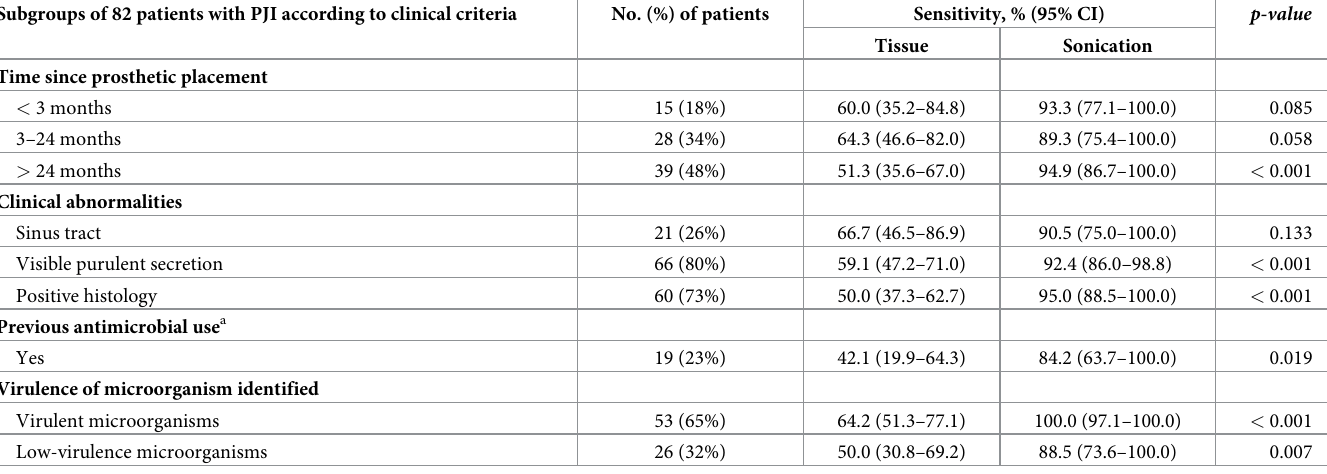
Table 4. Assessment of clinical and microbiological characteristics and sensitivity of tissue and sonication fluid cultures in patients clinically diagnosed with PJI. Subgroups of 82 patients with PJI according to clinical